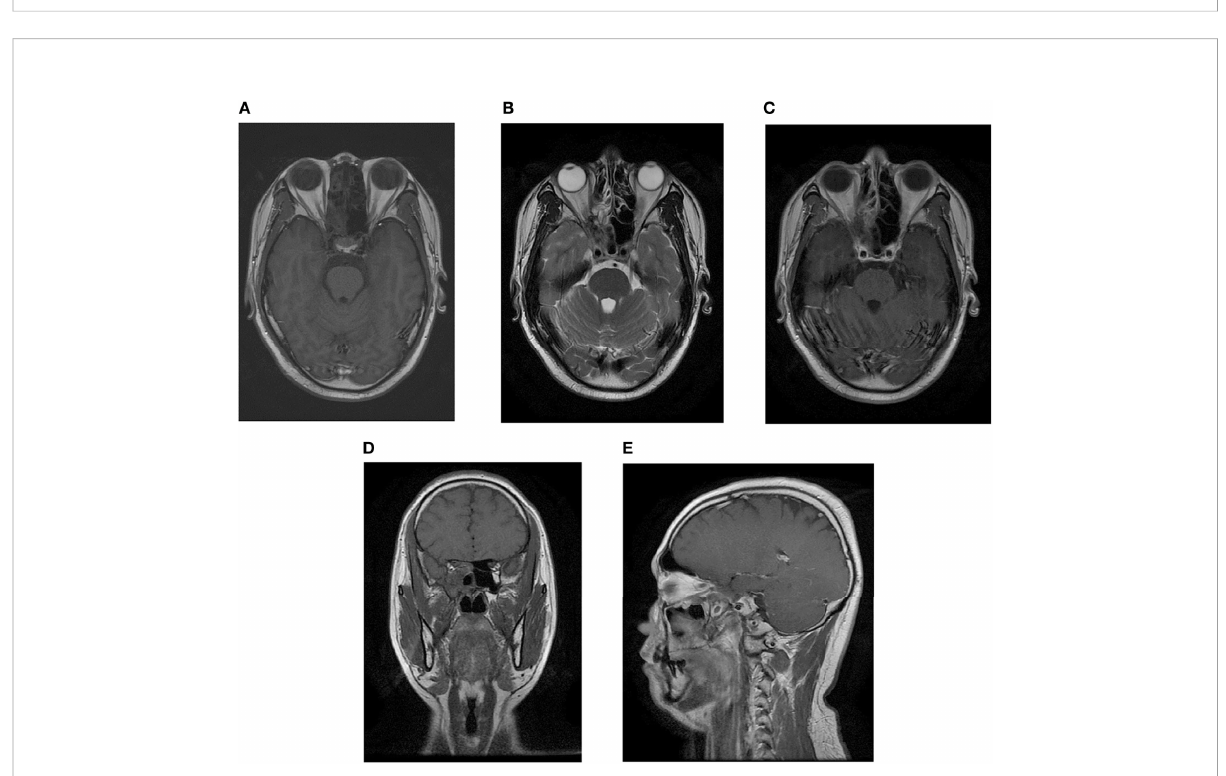
FIGURE 7 PostradiotherapyMRexaminationoftheparanasalsinus. TheMRexaminationdetectedacompleteremissionofthetumor. (A) Axial T1-weightedimage. (B) Axial T2-weightedimage. (C) AxialT1-weightedenhancedimage. (D) Sagittal T1-weightedenhancedimage. (E) Coronal